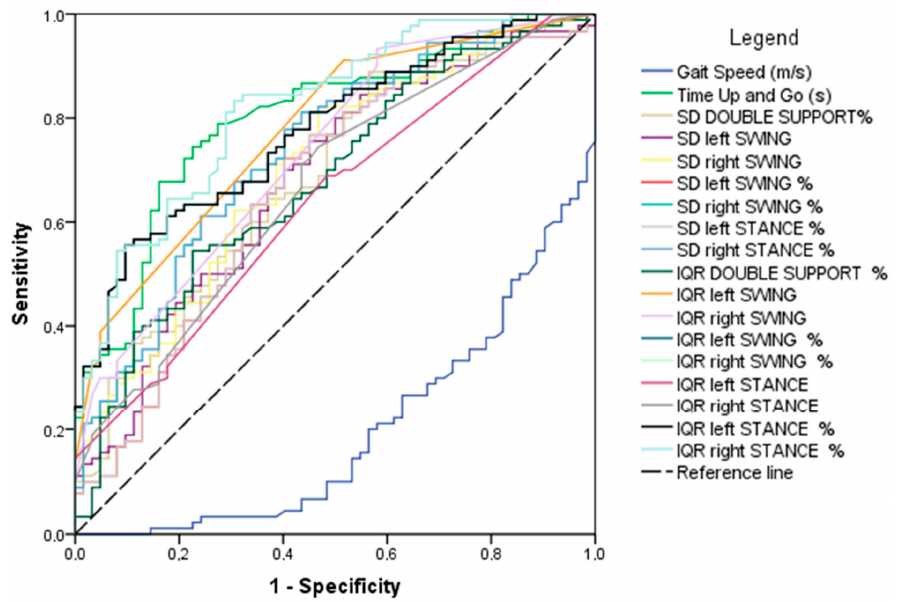
Figure 5. ROC graph of statistically significant kinematic features, considering a diagnosis as a target of PD over HS. IQR: interquartile range, SD: standard